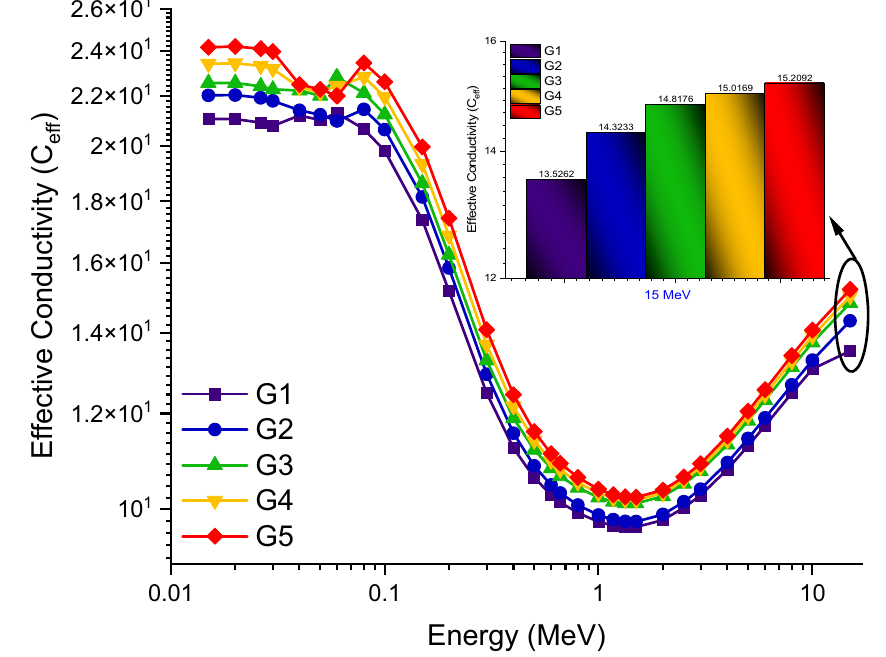
Figure 9: Variation of e ff ective electron density ( electrons/g ) with photon energy ( MeV ) for all G1 – G5